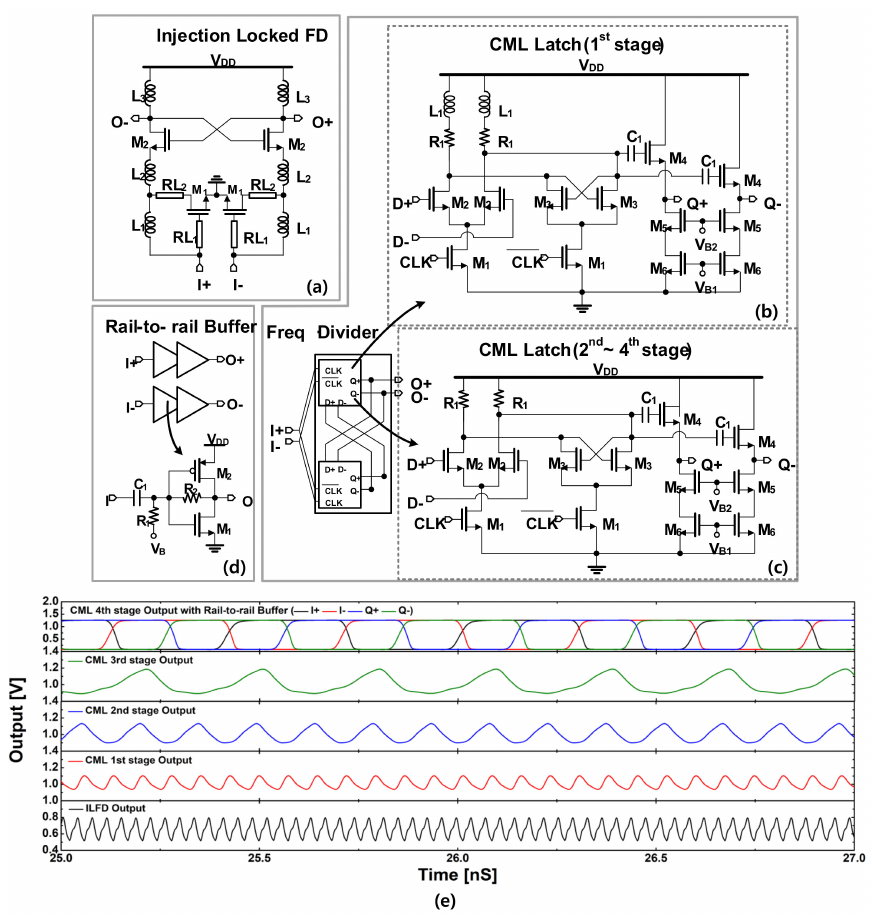
Figure 10. Schematic of the divider chain: ( a ) the injection-locked FD; ( b ) the first CML FD; ( c ) the sec- ond, third, and the fourth CML FD; ( d ) rail-to-rail buffer; ( e ) A simulation result of the divider